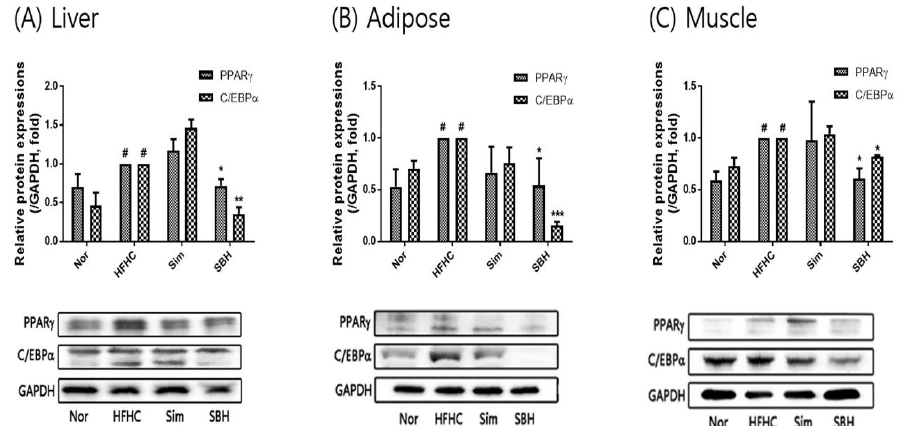
Figure 5. Expression of PPARγ and C/EBPα proteins in liver ( A ), adipose ( B ), and muscle ( C ) tissue. The number of experiments: Nor ( n = 3), HFHC ( n = 3), Sim ( n = 3), SBH ( n = 3). Data are expressed as the mean ± SEM. # p < 0.05 compared with Nor; * p < 0.05, ** p < 0.01, *** p < 0.001 compared with HFHC. Nor, normal control group; HFHC, high-fat and high-cholesterol diet group; Sim, HFHC diet plus Sim group; SBH, HFHC diet plus SBH group.